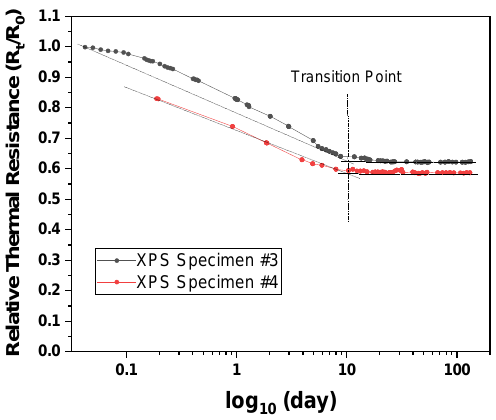
Figure 6. Conversion of relative thermal resistance.